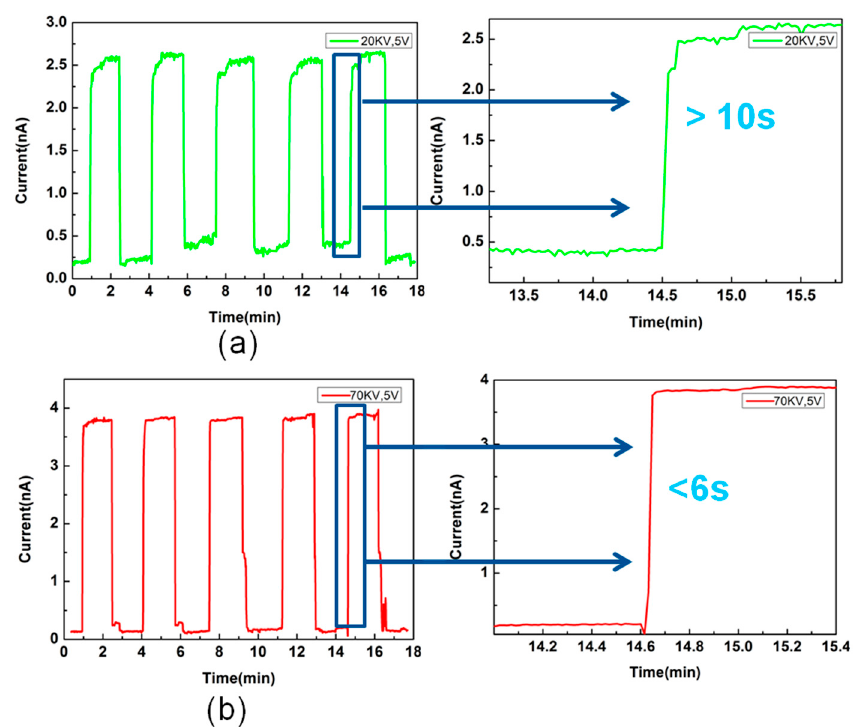
Figure 5. Reversible response curves of current-time (I-t) to NH 3 concentration of 50 ppm. ( a ) The graph is a 5-cycle test of a conventional fiber membrane electrospun under 20 kV (average fiber diameter of 263 nm) with a response time greater than 10 s. ( b ) The graph is a series of 5 cycles of an ultrafine fiber membrane electrospun under 70 kV (average fiber diameter of 68 nm) with a response time of less than 6 s. The test voltage was 5 V.